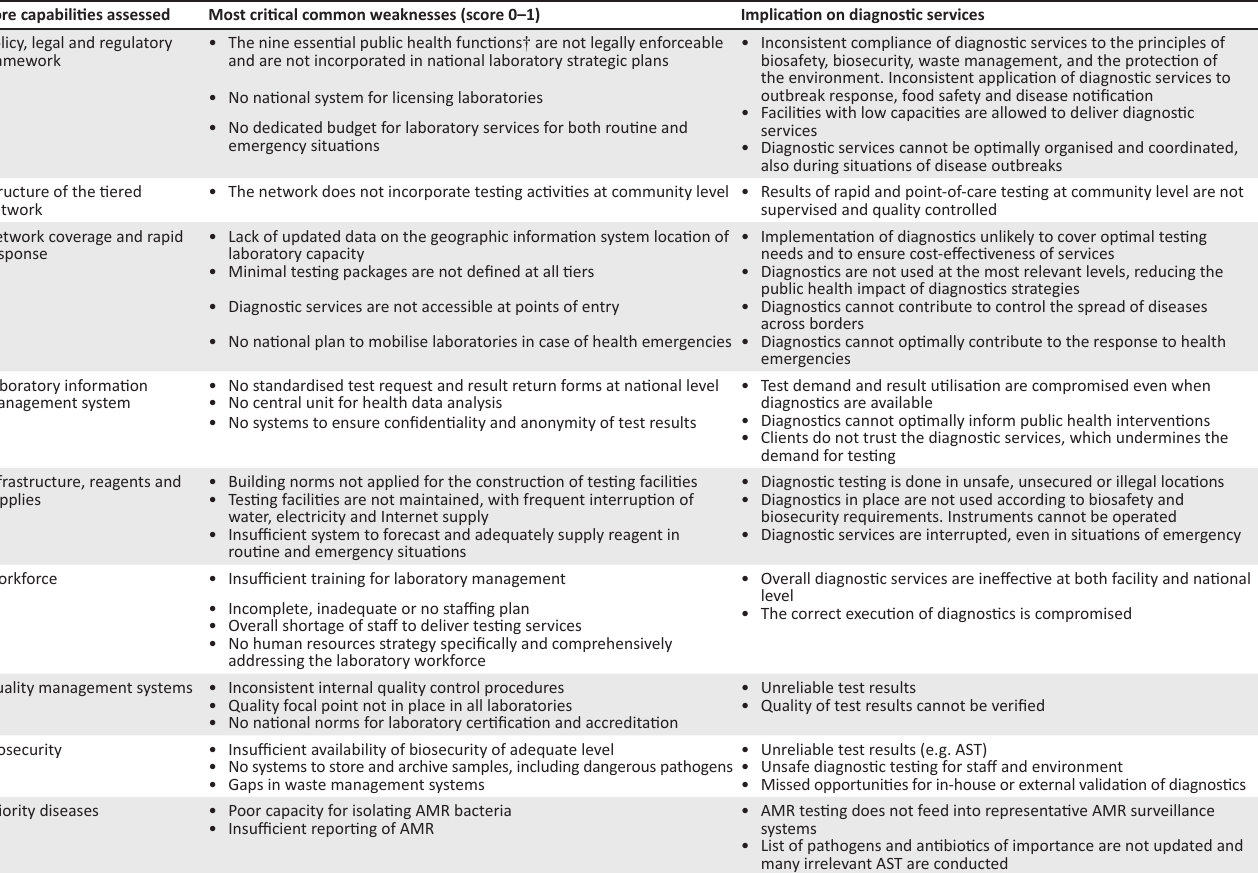
FIGURE 2: Overall level of laboratory network functionality in eight countries TABLE 1: Most critical gaps in laboratory network core capabilities were identified through the laboratory network assessment of eight sub-Saharan African countries between 2017 and 2019, and their implications for diagnostic services.